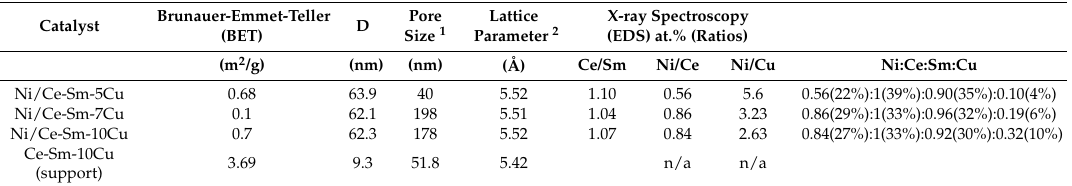
Figure 1. X-ray diffraction (XRD) patterns of the: ( a ) Ni/Ce-Sm-xCu (x = 5, 7, and 10 at.%) catalysts; ( b ) Ni/Ce-Sm-10Cu catalyst and Ce-Sm-10Cu support. Table 1. Textural properties of the Ni catalysts studied in this